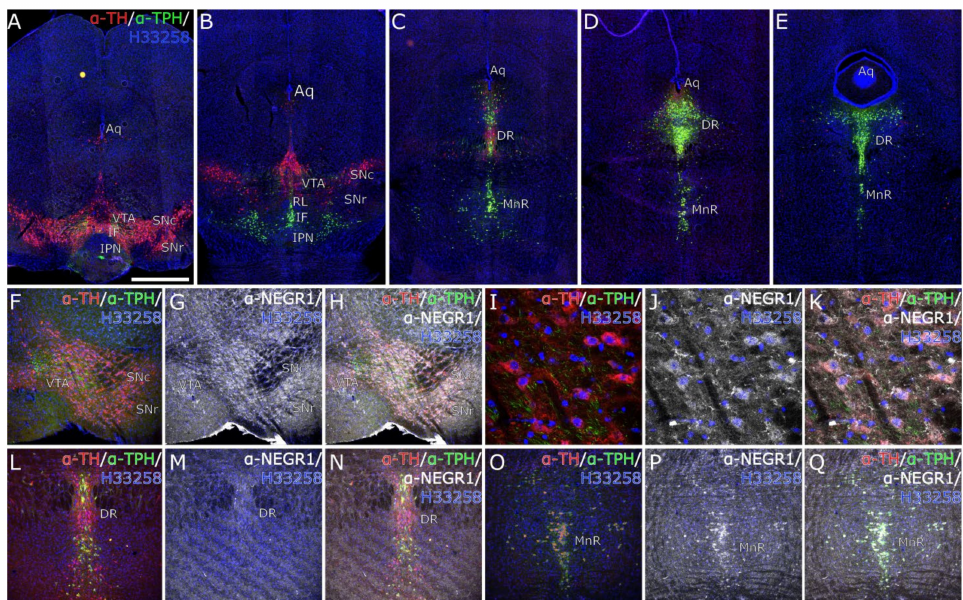
Figure 9. Immunohistochemical staining of WT mouse brain coronal sections displaying an expres- sion of tyrosine hydroxylase (TH), tryptophan hydroxylase 2 (TPH) with NEGR1. ( A – E ) epifluorescent images display localization of TH and TPH throughout dopaminergic and raphe nuclei. ( F – K ) laser scanning confocal microscope images displaying localization of NEGR1 in TH-positive cells in sub- stantia nigra pars reticulata (SNr). ( L – N ) laser-scanning confocal microscope images show diffuse localization of NEGR1 in the dorsal raphe (DR), whereas ( O – Q ) the localization in medial raphe (MnR) is observable in cells expressing TH and TPH. ( A – Q ) Nuclei were stained using H33258